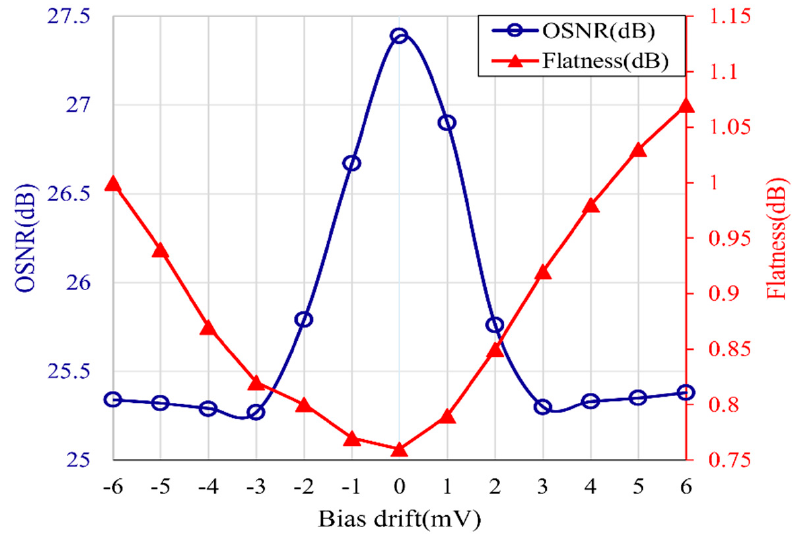
Figure 7. Influence of DC bias drifts on OSNR and flatness of optical frequency comb.